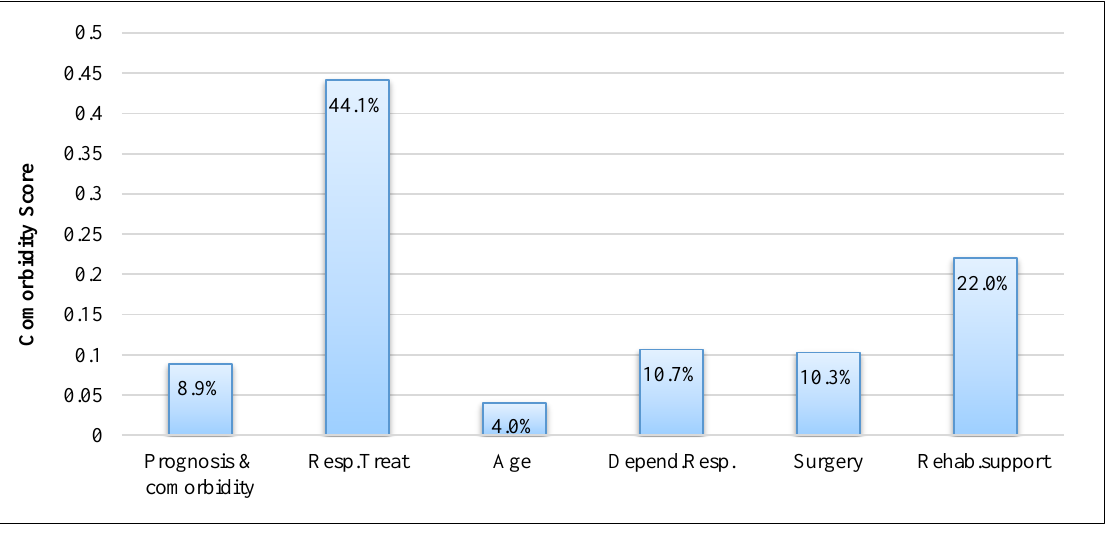
Figure 3. Expert 1 and 2 Evaluation (Factor Priority)